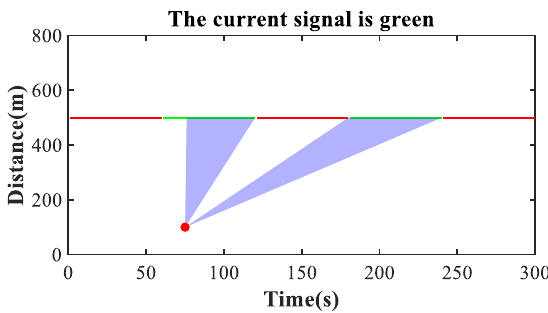
Figure 6. The color of the next target traffic light is green.